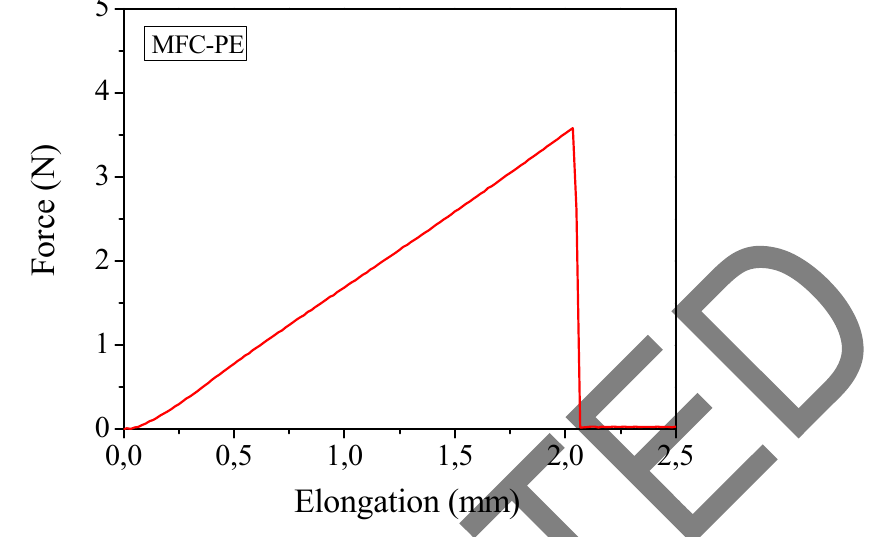
Figure 9. Mechanical measurements through traction test of the reinforced MFC-PE at ambient temperature.